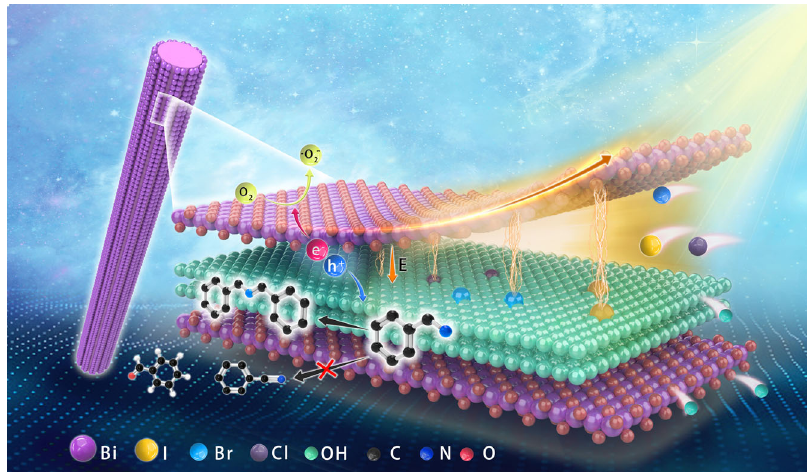
Fig. 1 Schematic illustration of IEF intensity change induced by ion exchange. The IEF intensity is strengthened for BOH nanorods using halide anions exchange, and the holes accumulated at the surface-exposed anion layers can be utilized to oxidize